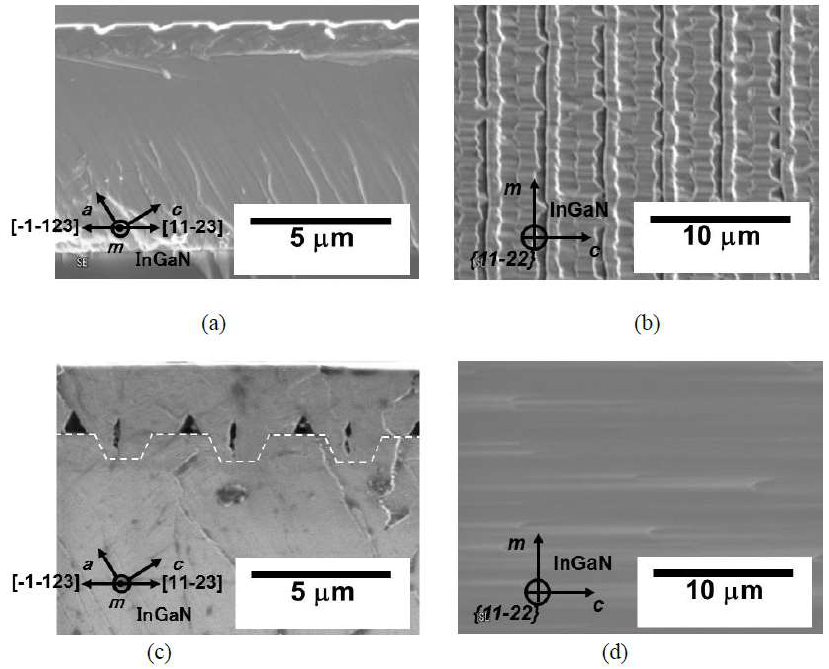
Figure 6. Cross-sectional and plan-view SEM images of the {11-22} InGaN layers grown on the InGaN template at a growth temperature of 800 °C, at the initial stage of growth ( a ) and ( b ), and after coalescence ( c ) and ( d ).